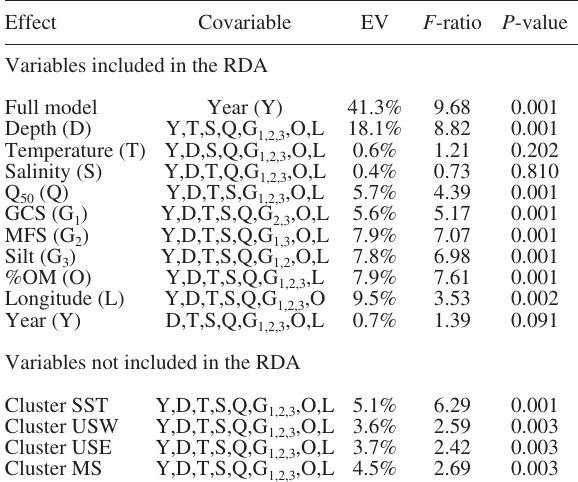
Table 4. – Results of the RDA for the species density matrix. The explained variance (EV), the F-statistic and its significance ( P -val- ue) for both the full model, which contains all the variables included in the model, and each individual variable after extracting the effect of the covariables is also indicated. Note that the sum of the EV for all variables is greater than 100% due to the shared